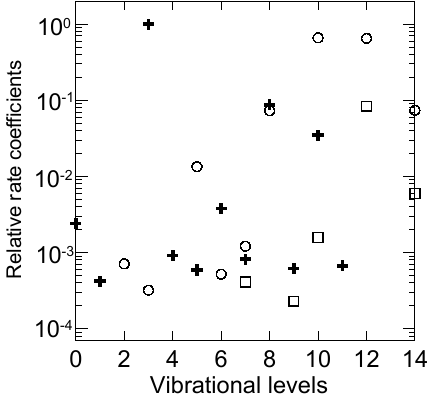
Fig. 7. The same as in Fig. 5 but for vibrational level v =2 of the Figure 7. The same as in Fig.5 but for vibrational level v=2 of the O 2+ (X 2 Π g ) ion. (X 2 5 g ) O + 2